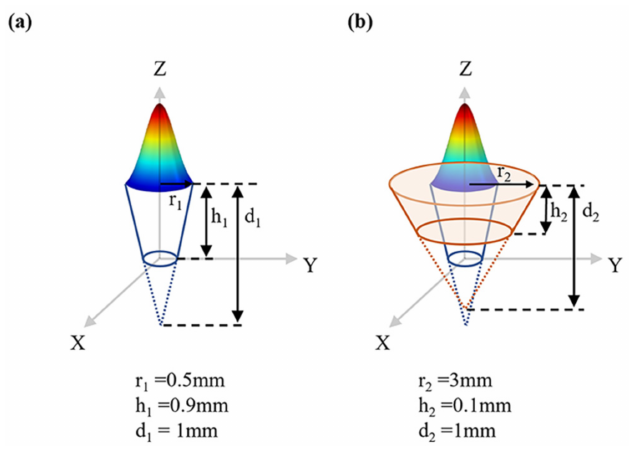
Figure 4. Gauss heat source model: ( a ) LW; ( b )